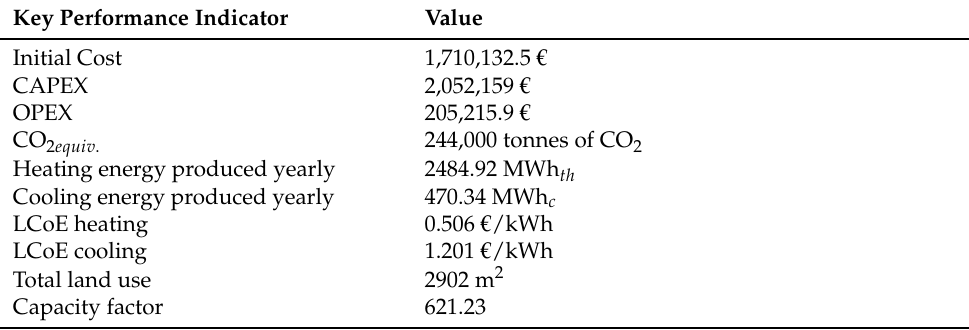
Table 9. Key Performance Indicators for the proposed